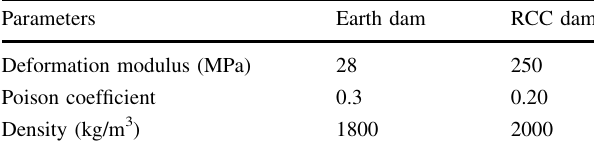
Table 7 Characteristics of dam’s materials